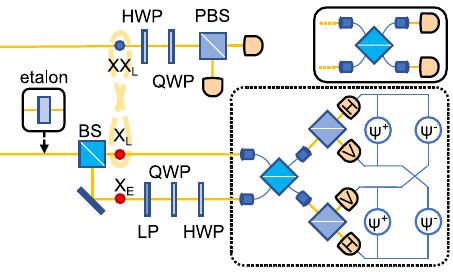
Fig. 2 Quantum teleportation using a QD photon emitter. Schematic illustration of the quantum teleportation setup. The BSM is implemented as shown in the dashed box, with a non- polarizing beam splitter (BS) followed by two polarizing beam splitters (PBS) at its output ports, allowing for the detection of two different Bell states. In the solid boxes, we highlight the setup variations compared in this work. The detectors on the same side of the BS can be grouped to simulate the simpler procedure without polarization-selective elements. The X photons can be fi ltered with an etalon whose bandwidth is approximately twice the radiative linewidth of the QD